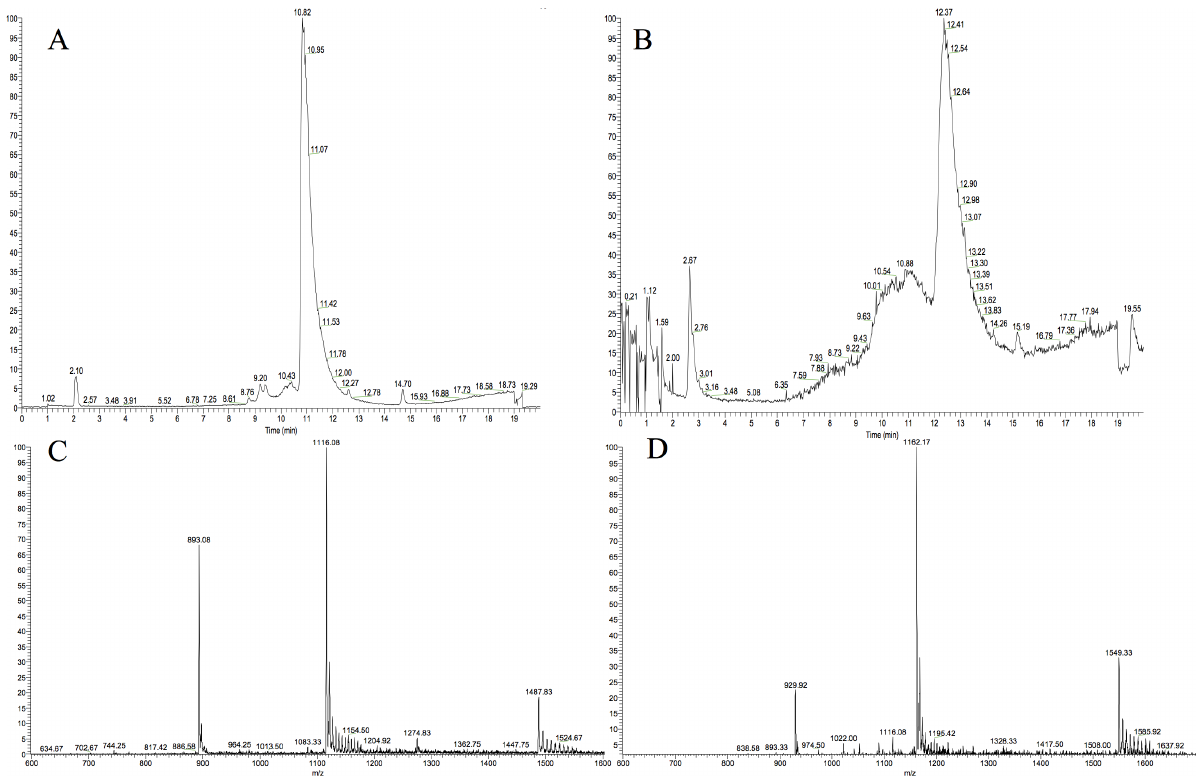
Fig 4. LC-MS analysis of MA β 1 – 40 and MA β 1 – 42 . A. LC trace of MA β 1 – 40 monitored by mass detection. B. LC trace of MA β 1 – 42 monitored by mass detection. C. MS of MA β 1 – 40 displaying [M+5H] 5+ , [M+4H] 4+ , and [M+3H] 3+ peaks (expected values: 892.65, 1115.56, 1487.07). D. MS of MA β 1 – 42 displaying [M+5H] 5+ , [M+4H] 4+ , and [M+3H] 3+ peaks (expected values: 929.47, 1162.17, 1548.44).